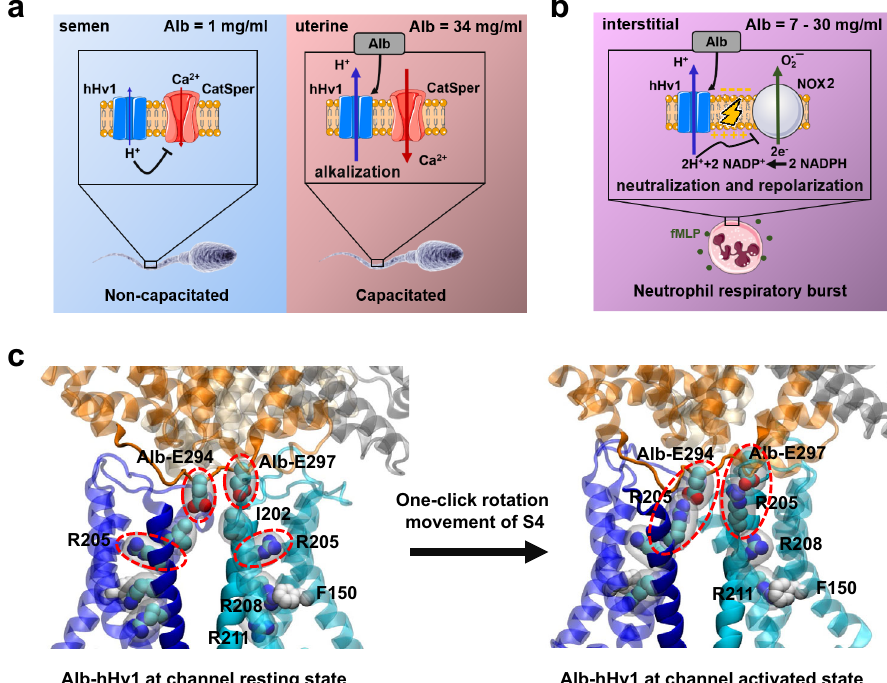
Fig. 7 Physiology of Alb activation of hHv1 in human sperm and neutrophils and proposed molecular mechanism. a The higher level of Alb in the female reproductive tract activates hHv1 in sperm leading to H + ef fl ux and cytosolic alkalization, initiating capacitation by potentiating CatSper. The synergy of hHv1 and CatSper in human sperm capacitation has previously been described 5 – 7 . b Activation of hHv1 in neutrophils by Alb potentiates H + ef fl ux, maintaining physiological pH i and compensating for the depolarization caused by NOX2, enhancing enzyme activity and allowing sustained ROS production. During the neutrophil respiratory burst (here, stimulated by fMLF), NOX2 translocates electrons from NADPH across the membrane to reduce O 2 to O 2 · - ; this ef fl ux of electrons generates H + in the cytoplasm and depolarizes cells, inhibiting the activity of NOX2 5,8 – 10 . c Alb activation of hHv1 is proposed to proceed by an electrostatic gating modi fi cation mechanism. Two binding sites in the Alb DII domain interact with the two S3-S4 loops in hHv1 channels. The two Alb sites each have an adjacent negatively-charged residue (Alb-E294 and Alb-E297) that attracts the fi rst channel gating charge (hHv1- R205) to facilitate outward movement of the voltage sensors and stabilizes the sensors in the activated “ up ” conformation. Side chains of three gating charges (R205, R208, and R211), the “ hydrophobic gasket ” formed by F150 that separates the internal and external aqueous solutions 73 , and I202, one helical turn above R205, are shown on hHv1 subunit A